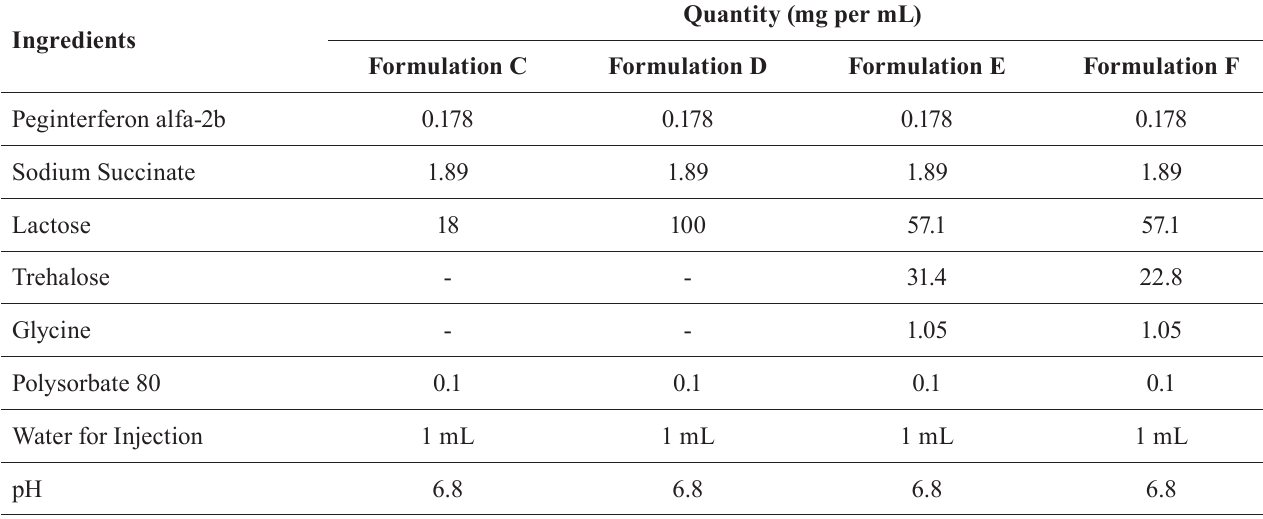
TABLE II - Peginterferon alfa-2b formulated in succinate buffer with different cryoprotectant(s)